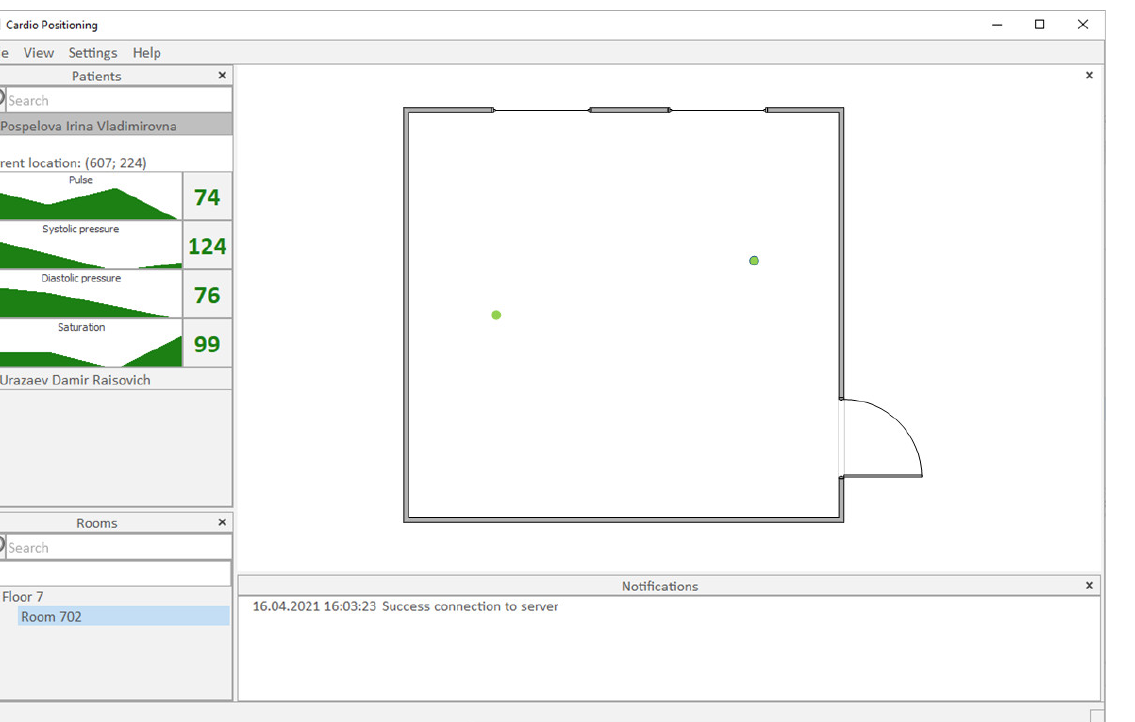
Figure 6. The graphical user interface of the OWS.